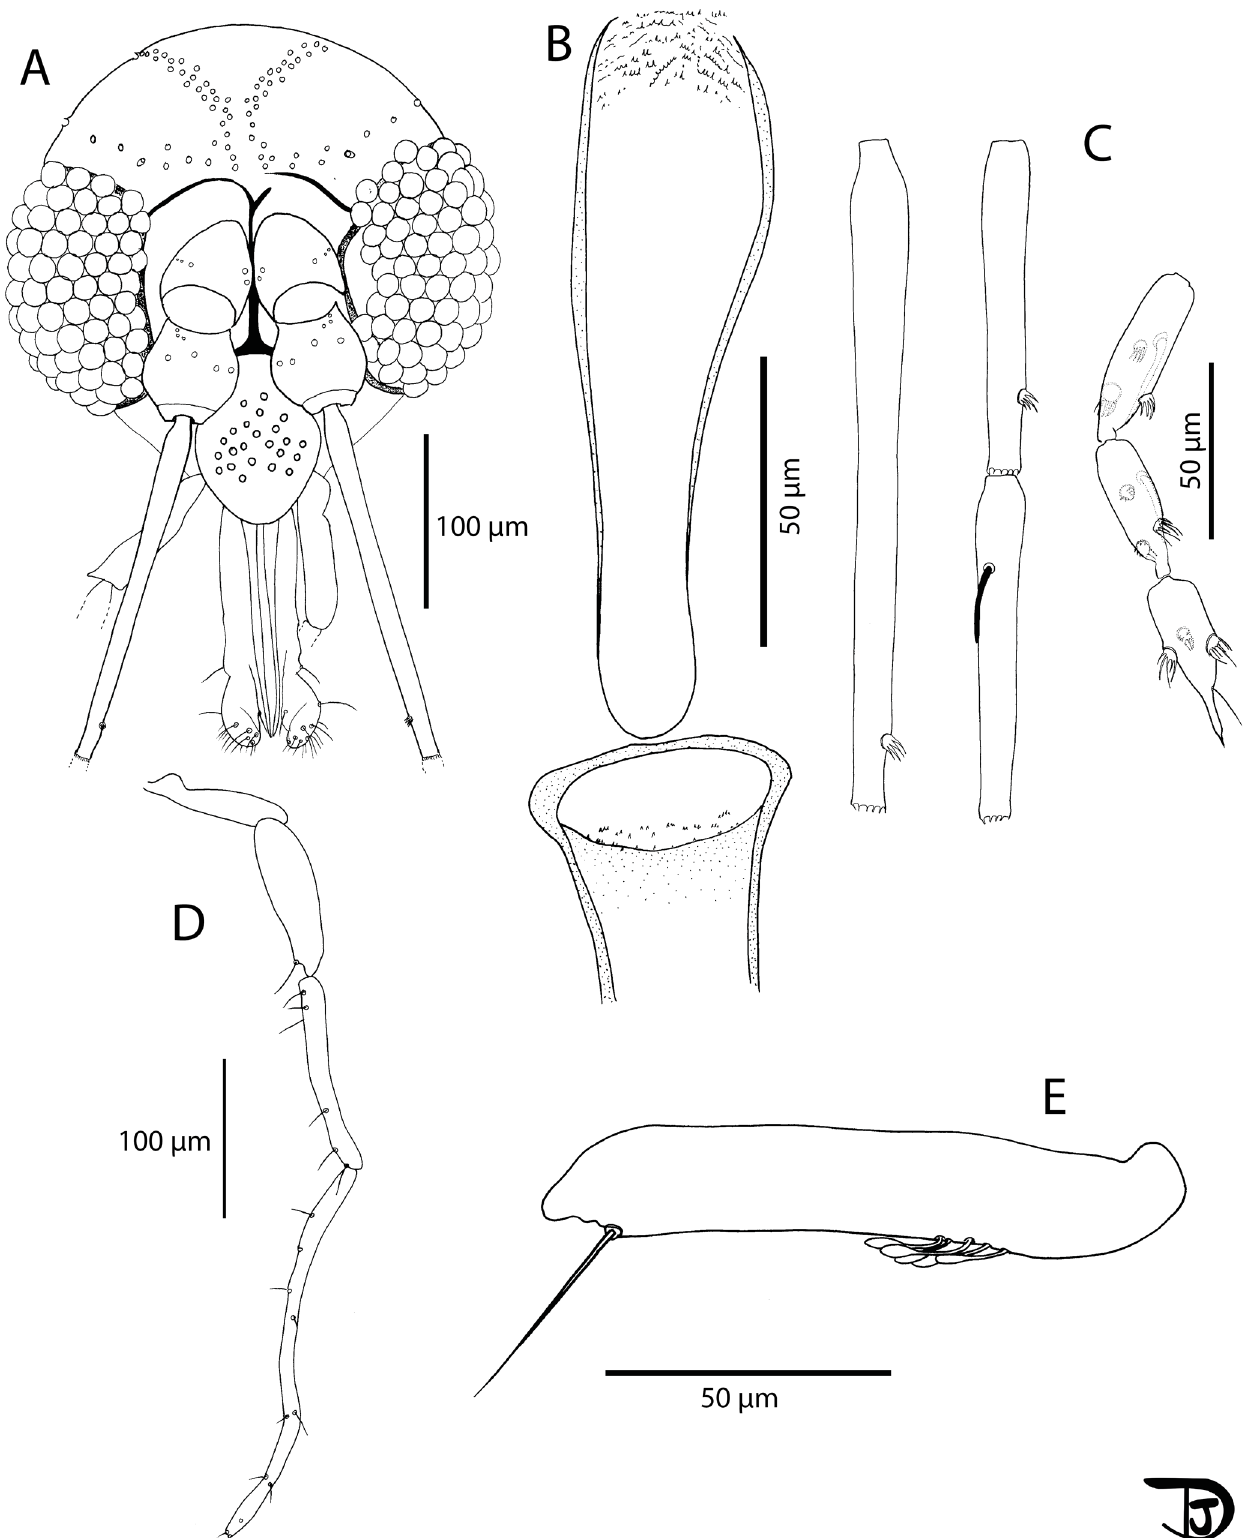
Figure 10. Sergentomyia (Ranavalonomyia) vol fi n. sp. male. (A) head (paratype MADA825), (B) pharynx and cibarium (paratype MADA825), (C) fl agellomeres 1, 2, 3, 12, 13 & 14 (paratype MADA899), (D) third palpal segment (paratype MADA825), (E) palp (paratype